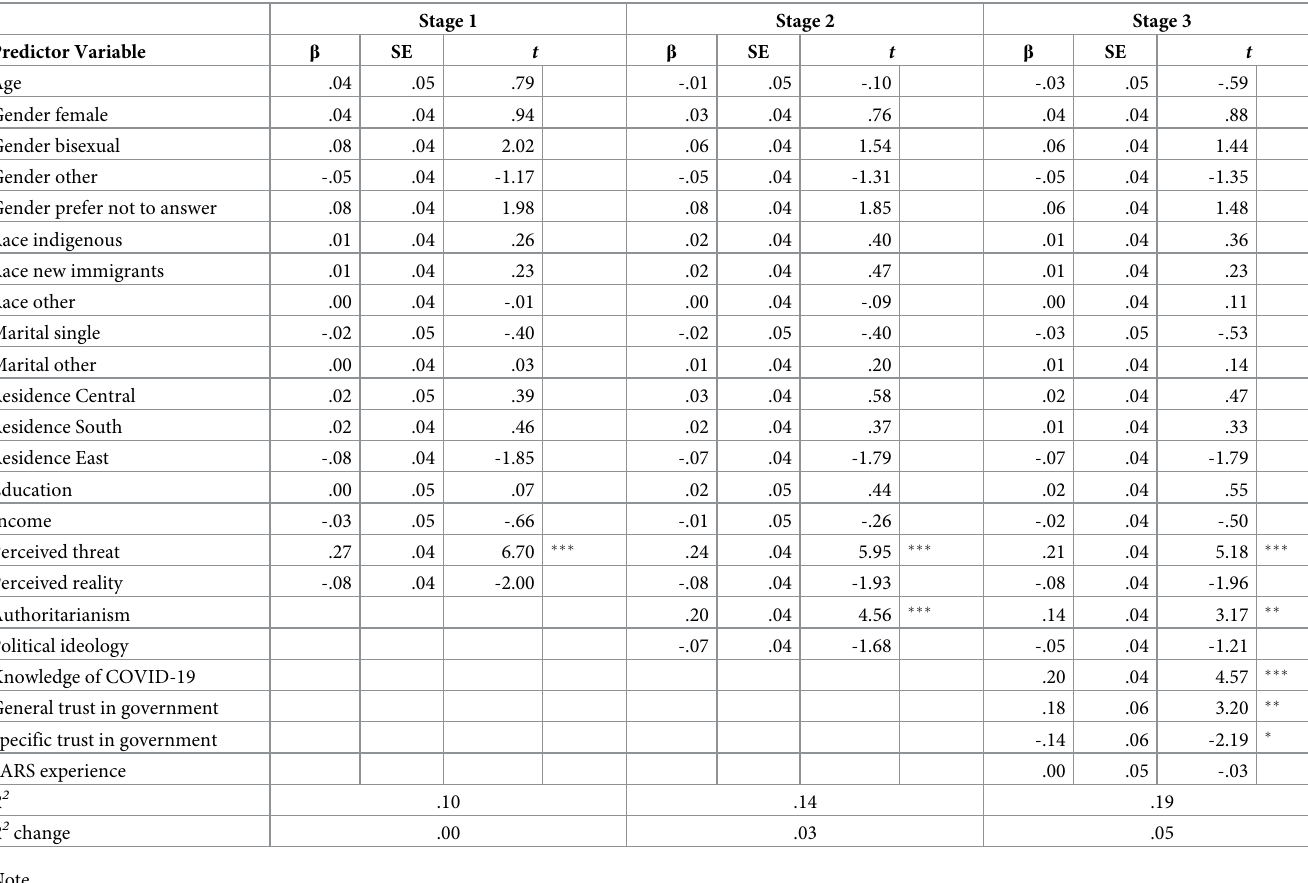
Table 6. Hierarchical regression analysis of predictors of mask-wearing (Taiwan